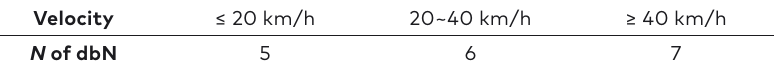
Table 2. Recommended of N of dbN Method